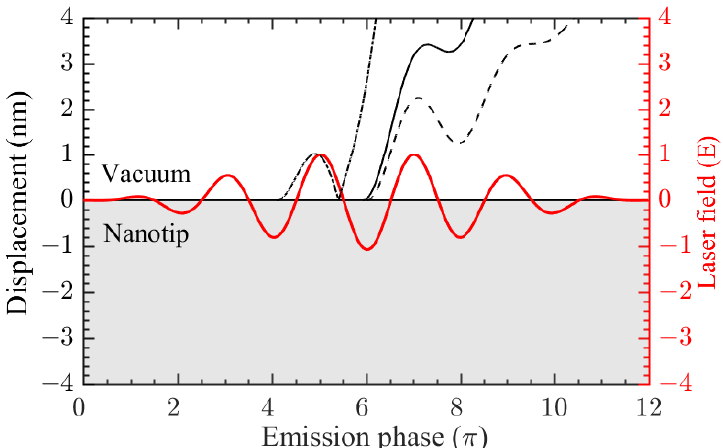
Figure 5. (color online) Extracted classical electron trajectories from nanotip photoemission (black lines). The red solid curve is the time profile of laser electric field. The laser parameters are the same as those of 1600nm in Figure